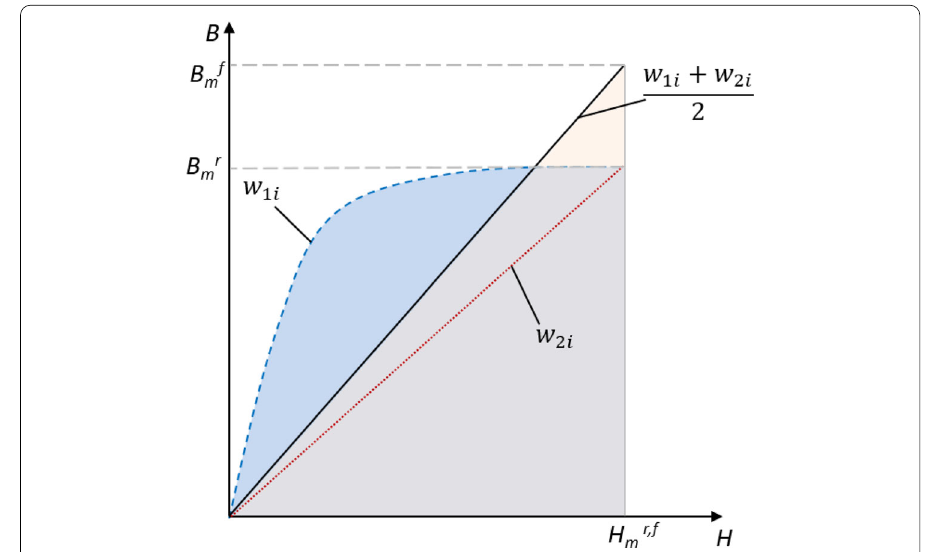
Fig. 3 B–H curve representation for real (blue dashed line), liniarized (red dotted line) and liniarized fictitious material (black solid line) [4,15,16]. Note: The reader is referred to the web version of this paper for interpretation of the references in